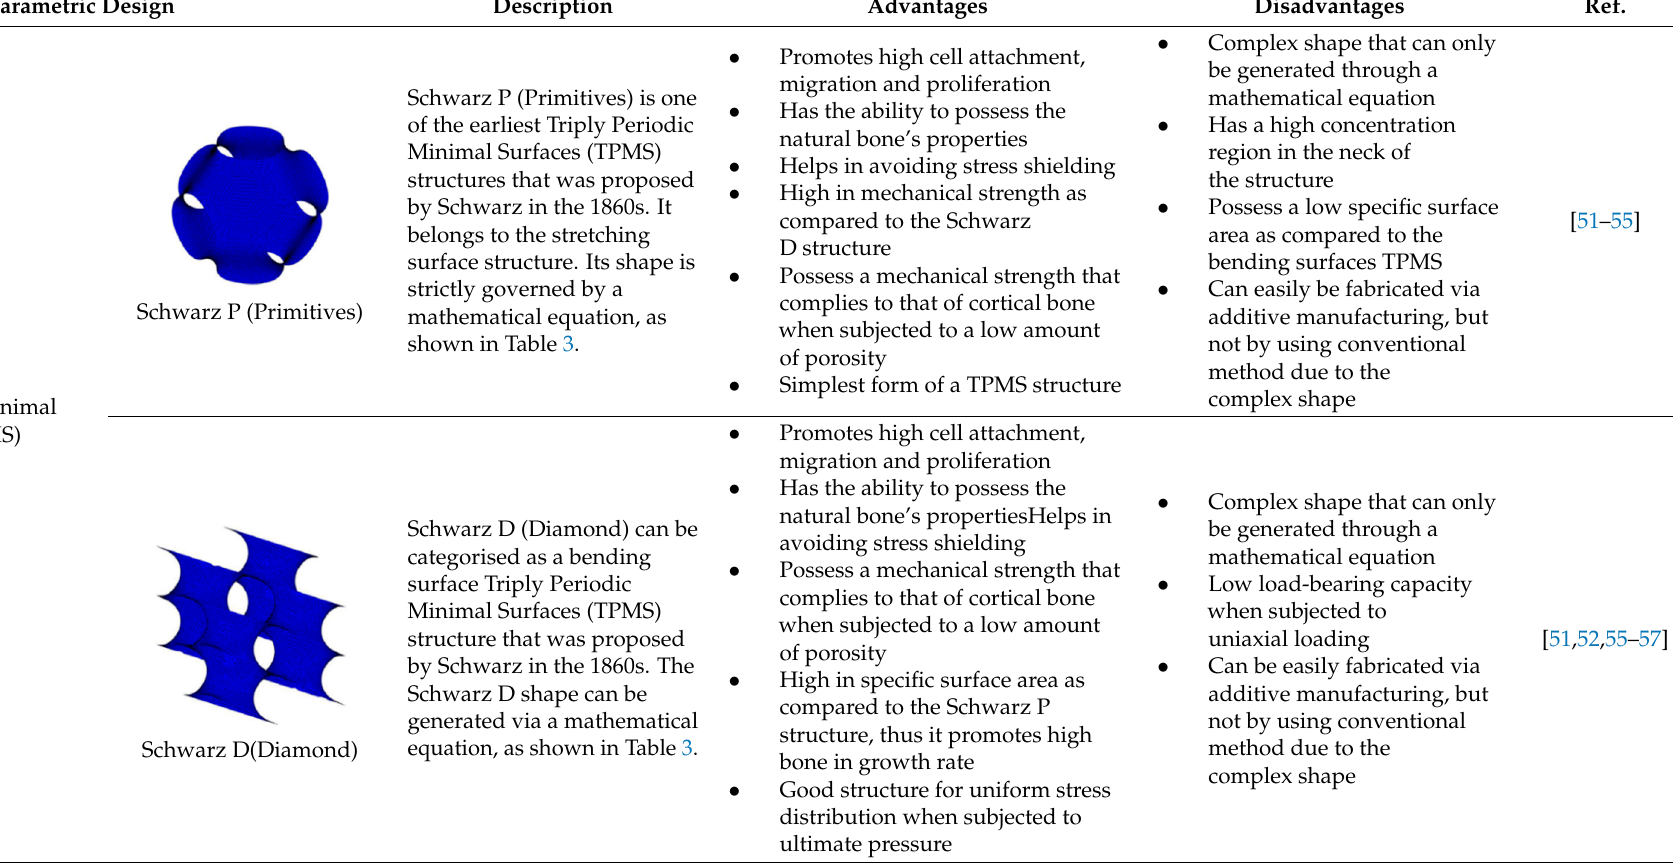
Table 2. Parametric design and its characteristics.